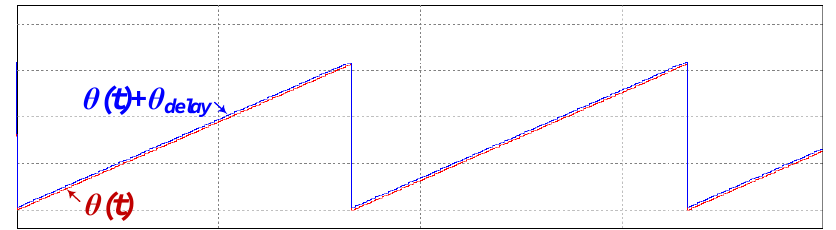
Figure 23. Simulation results of the real phase angle and compensated phase angle.